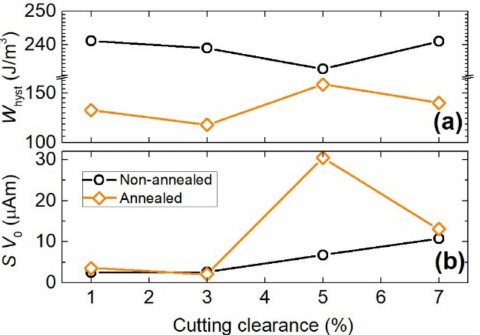
Figure 10. Comparison of ( a ) hysteresis loss and ( b ) statistical quantity SV 0 in the investigated steels before and after annealing. ( a ) is obtained experimentally and ( b ) is predicted